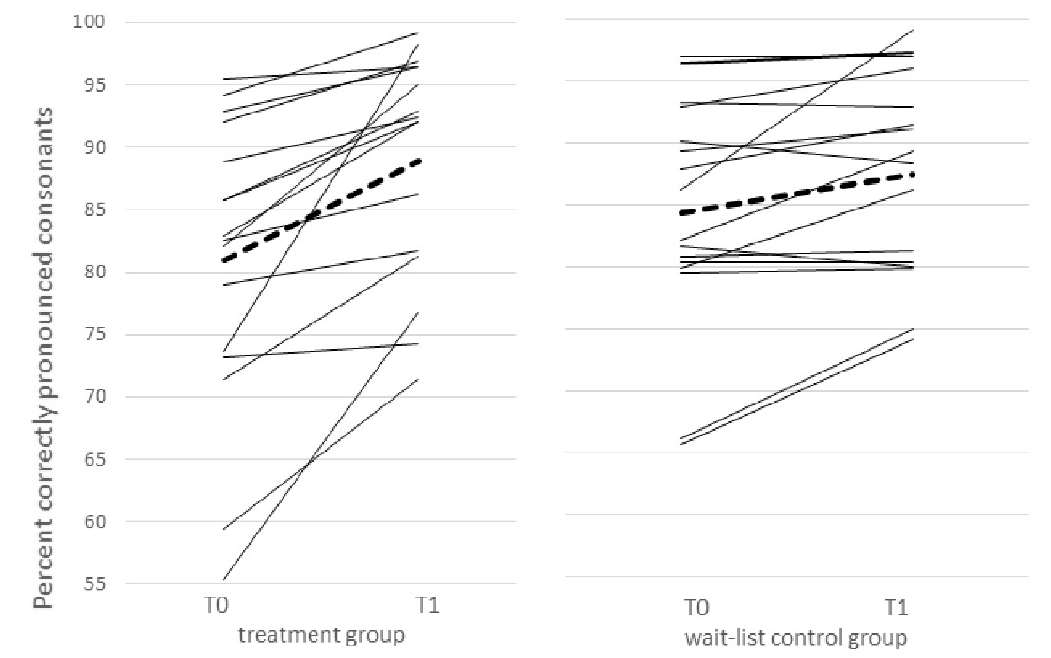
Figure 3. Change in PCC scores for each participant from time point To to T1, for treatment group and wait-list control group; solid lines: individual scores; dashed lines: means.